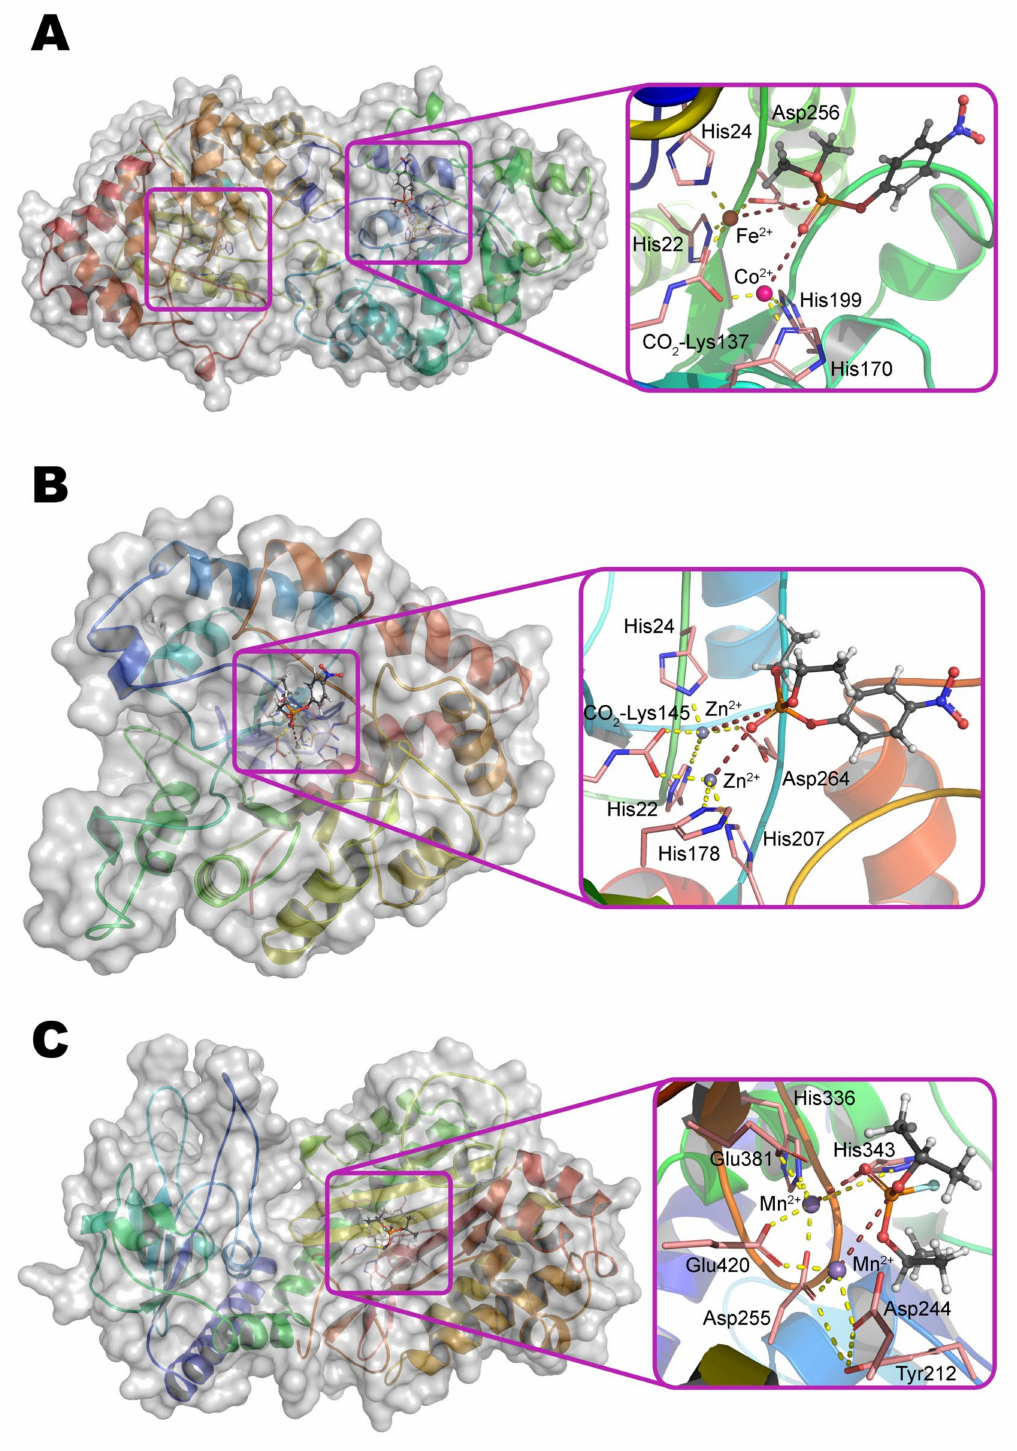
Figure 4. The structure of SsoPox dimer ( A ), mPHP monomer ( B ), and OPAA dimer ( C ) according to X-ray diffraction data (PDB 3UF9, 4IF2, and 3L24, respectively). The entrance to the active centers of the enzymes is framed, and their structures are shown in detail within insets. The binding of the substrate methyl paraoxon ( A ), paraoxon ( B ), and diisopropyl fluorophosphate ( C ) was determined as previously. The coordination bonds of metal ions with amino acid residues in active centers, as well as with labile groups of the substrate are shown by a dashed